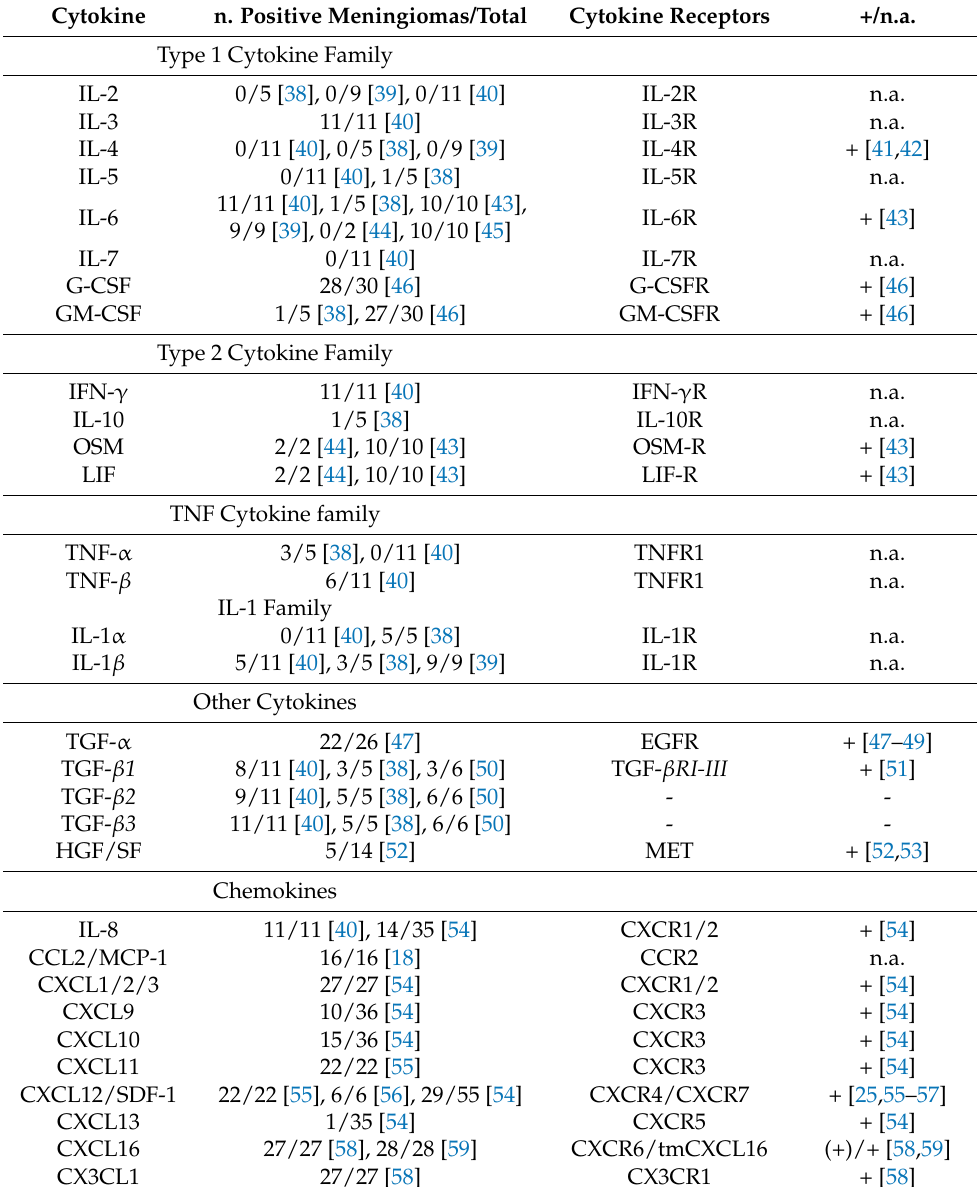
Table 1. Overview of cytokines and cytokine receptors expressed in meningiomas ranging from WHO grade I–III. Cytokines are key mediators of crosstalk in other primary brain tumours. A better understanding of the cytokine microenvironment is essential to explore the role of the brain parenchyma in the pathogenesis of meningiomas. “+” indicates that the receptor has been detected in meningioma tumour cells. Abbreviations: n.a. = not